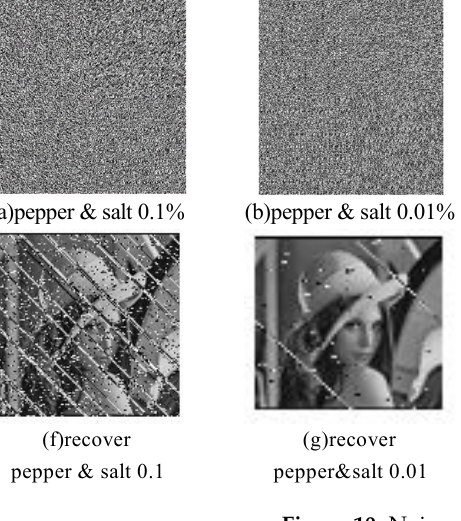
Figure 10. Noise effect on ciphertext and recovery image in different degrees.